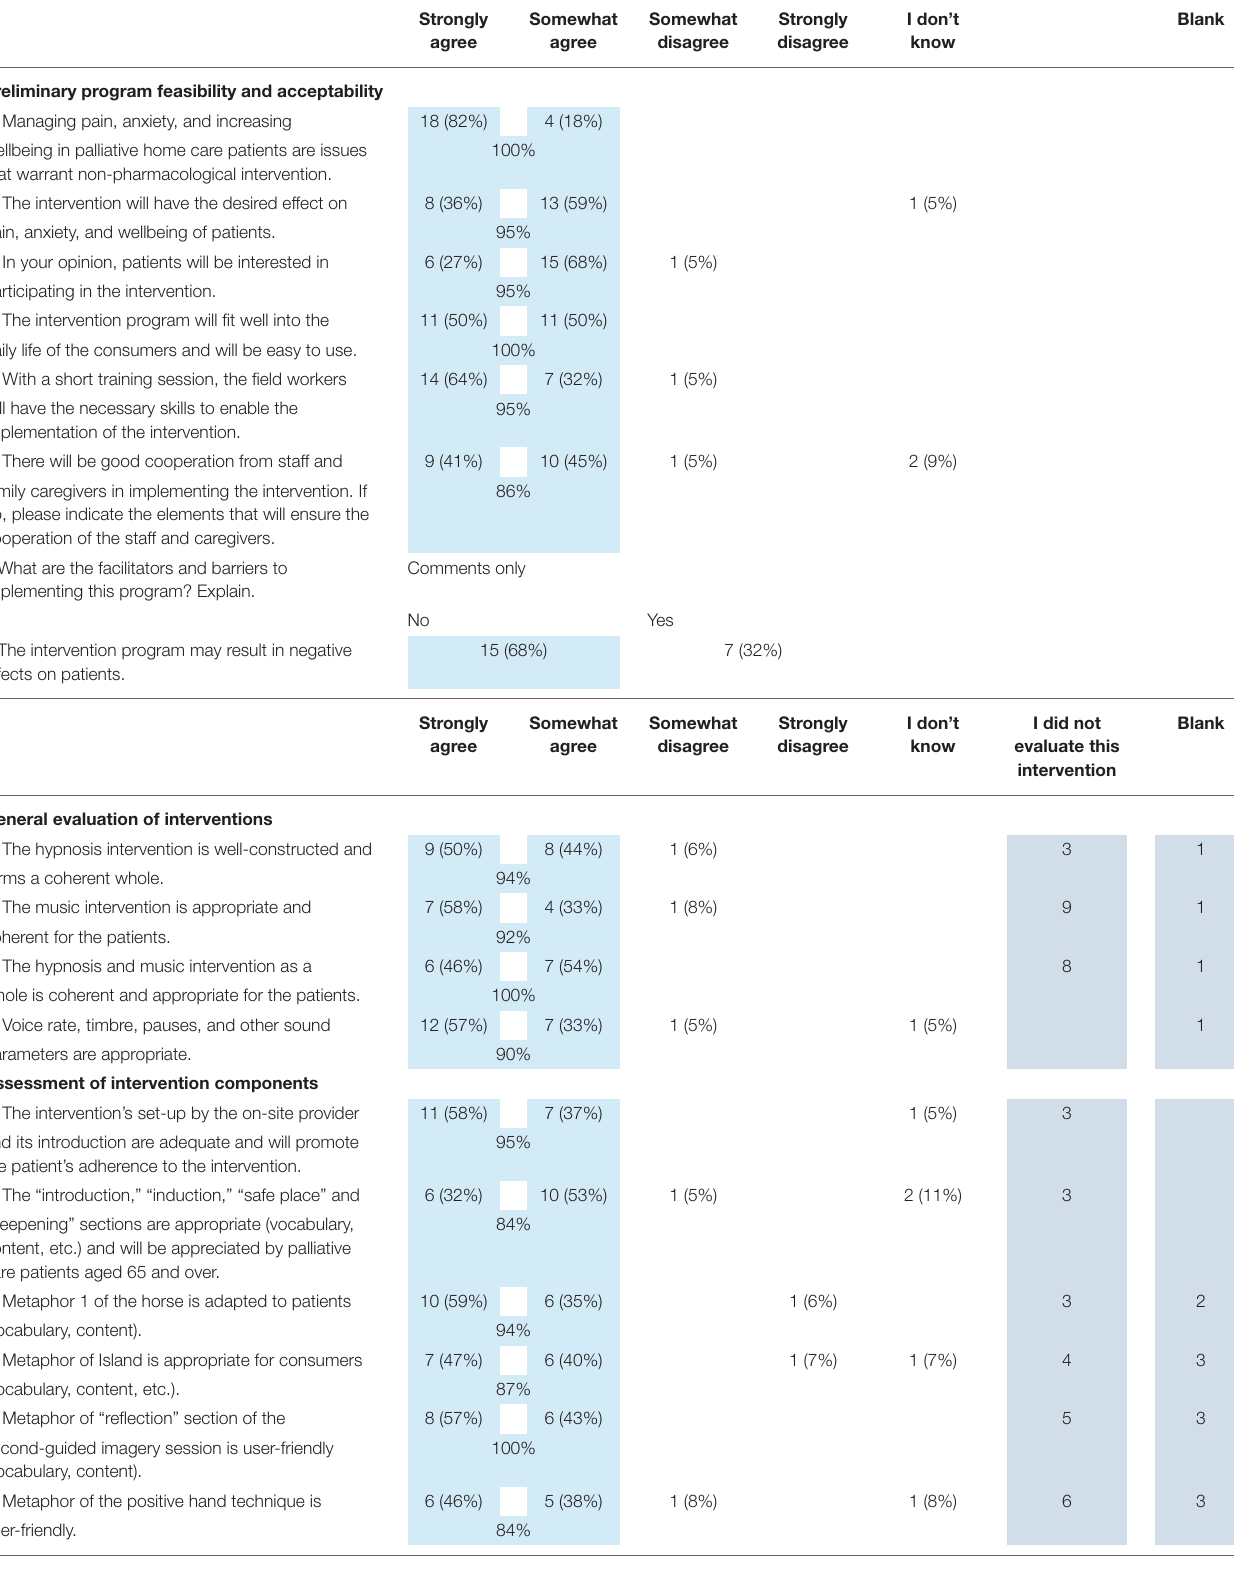
TABLE 4 | Questionnaire 1.